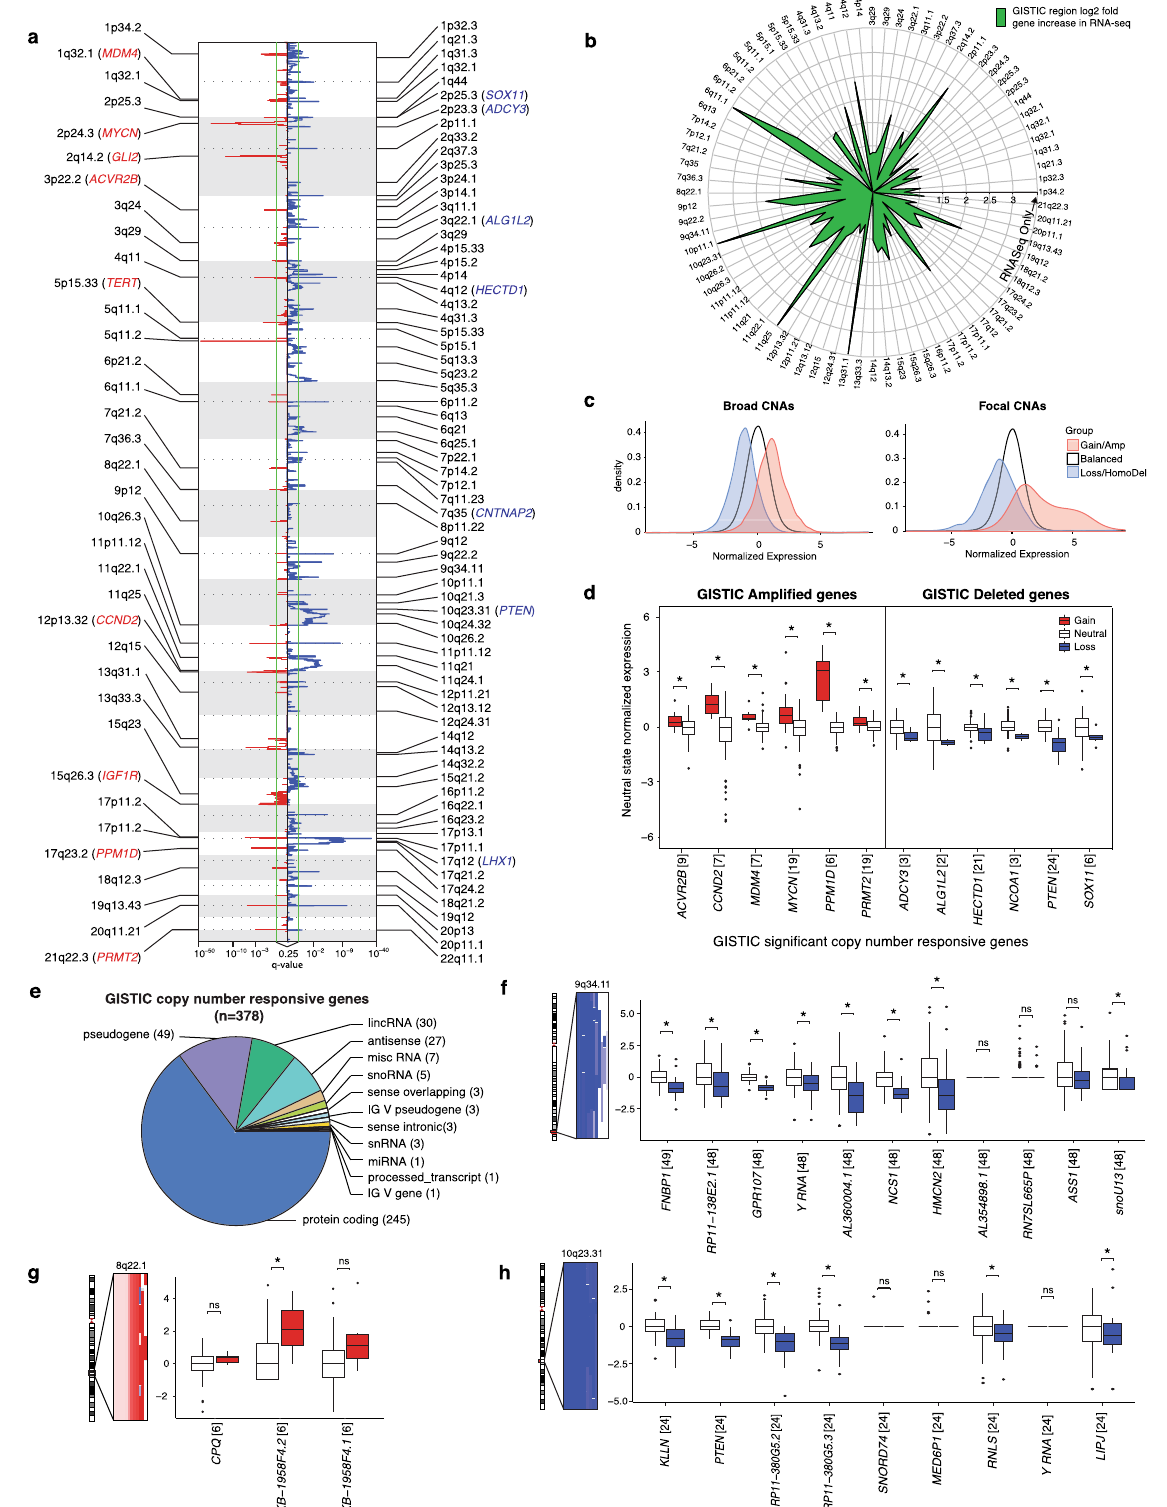
responsive genes within CNAs are likely to a poor choice for the development of targeted